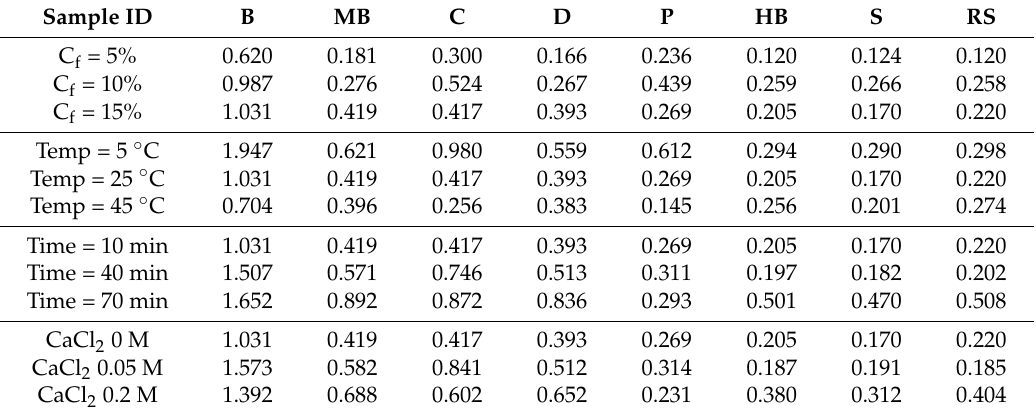
Table 2. Root mean square error obtained by various rheological models for specimen